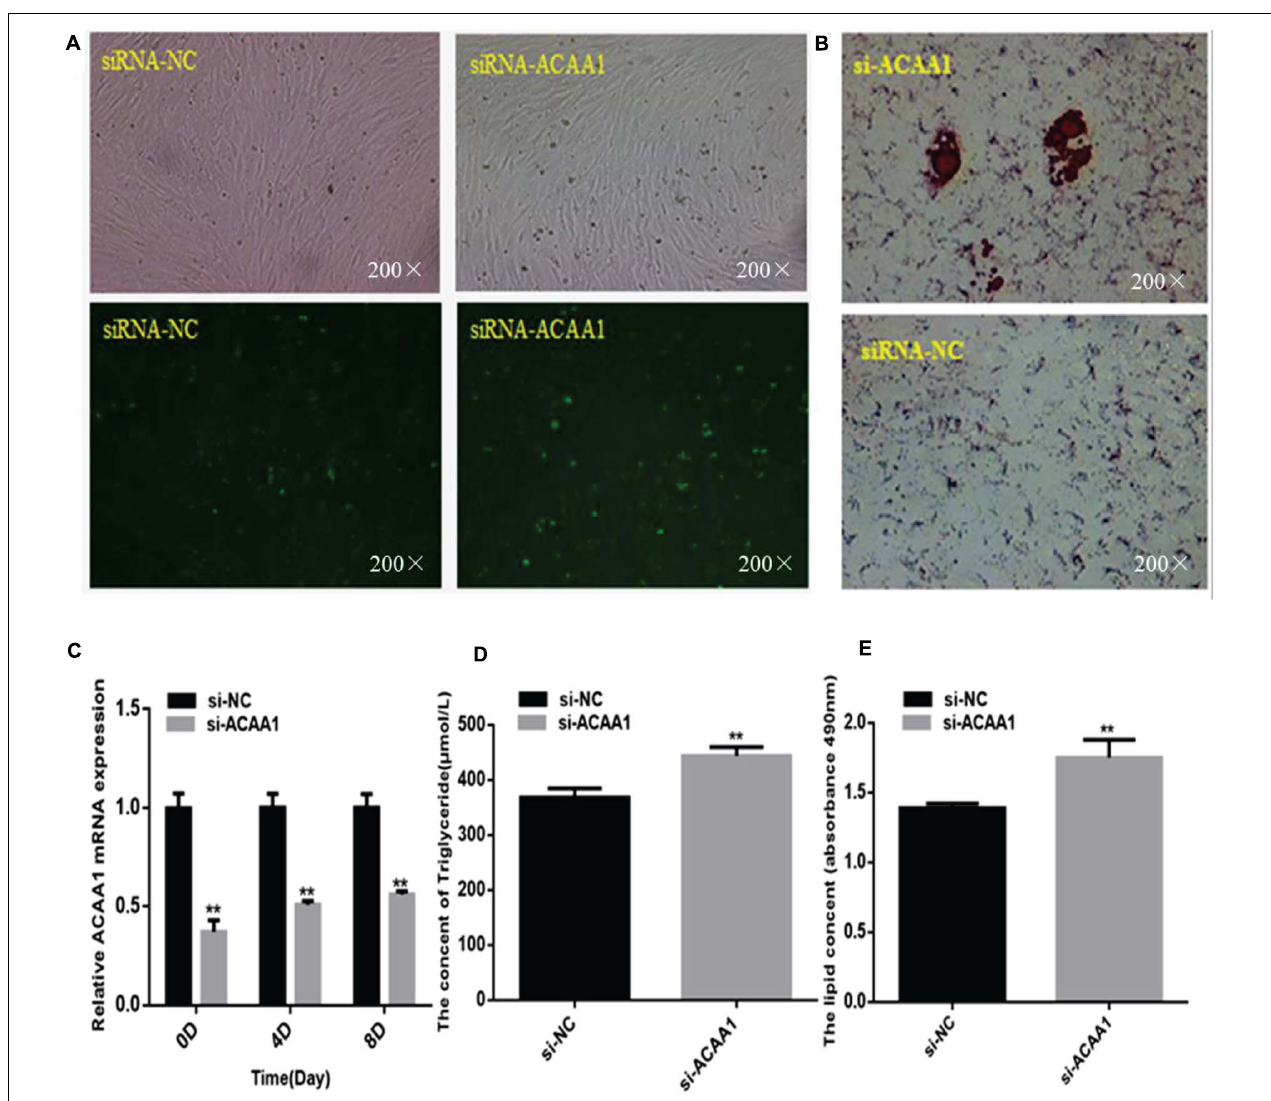
FIGURE 2 | ACAA1 knockdown increases lipid accumulation and the triglyceride content during sheep preadipocyte differentiation. (A) Determination of the transfection efficiency of siRNA-ACAA1 (200 × ). (B) After 8 days of differentiation, the cellular lipid droplets were stained with oil red O (200 × ). (C) ACAA1 mRNA expression was detected after siRNA-ACAA1 or NC transfection on days 0, 4, and 8 of adipogenic differentiation. The siRNA-ACAA1 groups all showed significantly lower expressions than the control group (** p < 0.01). (D) The triglyceride content after 8 days of induction in the siRNA-ACAA1 group was significantly higher than that in the control group (** p < 0.01). (E) The lipid droplet content measured at 490 nm after 8 days of induction was significantly higher in the siRNA-ACAA1 group than that in the control group (** p < 0.01). siRNA , small interfering RNA; NC , negative